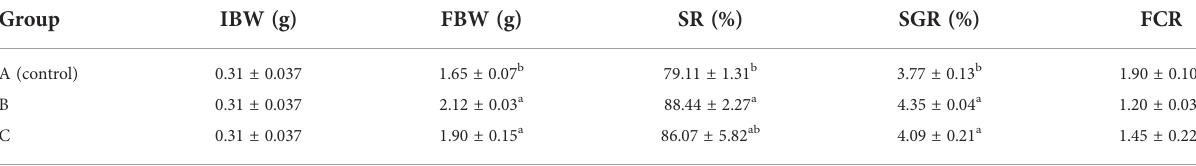
TABLE 1 Effects of sodium humate (B) and sodium humate with Probiotics (C) on growth performance of L.vannamei .